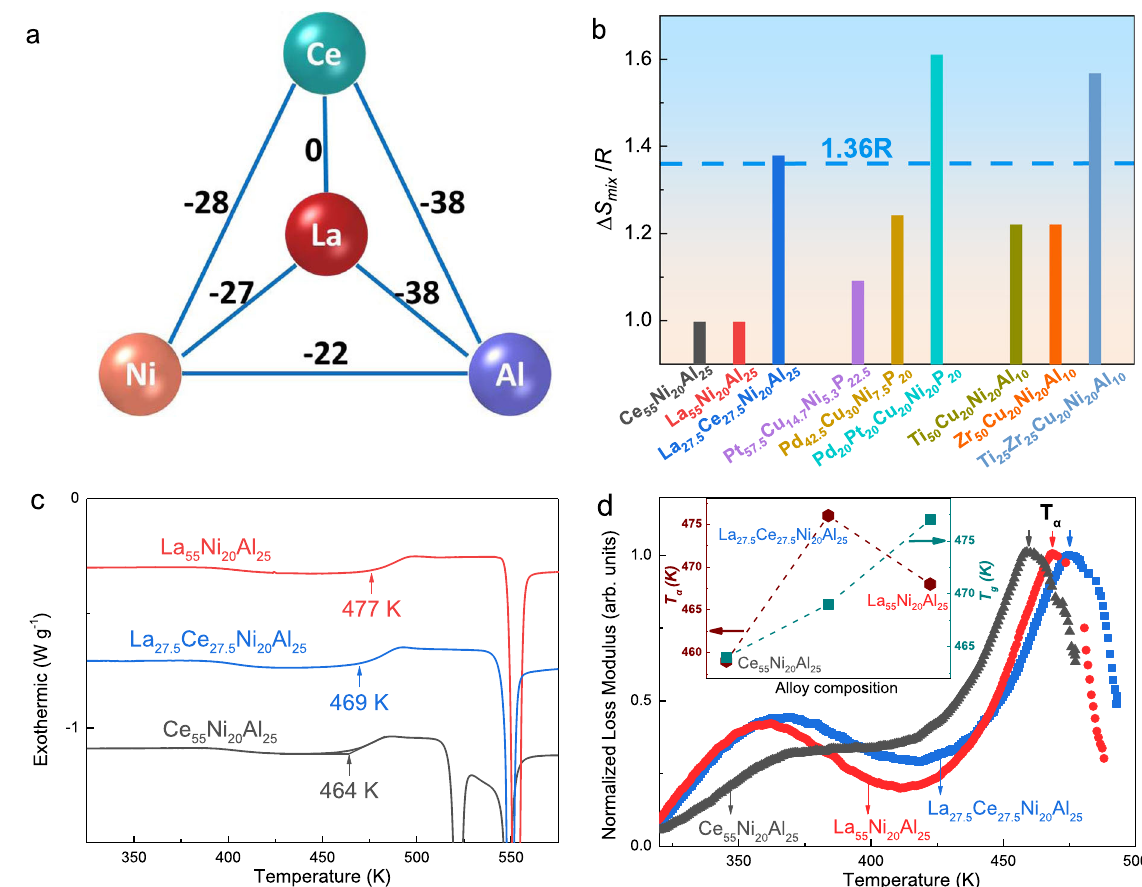
Fig. 1 The mixing of entropy, calorimetric, and dynamical behaviors. a Δ H mix (kJ mol − 1 ) for the constituting atomic pairs in the La(Ce)NiAl system. b Calculated entropies of mixing for the three MG systems. c DSC traces of the La(Ce)NiAl system with a heating rate of 0.33 K s − 1 . The arrows indicate the calorimetric glass-transition temperature ( T g ). d Temperature dependence of the loss modulus of the La(Ce)NiAl system at 1 Hz with a constant heating rate of 0.05 K s − 1 , normalized by the maximum peak value. The arrows indicate the α -relaxation temperature ( T α ), and the inset shows the evolution of T g and T α with the